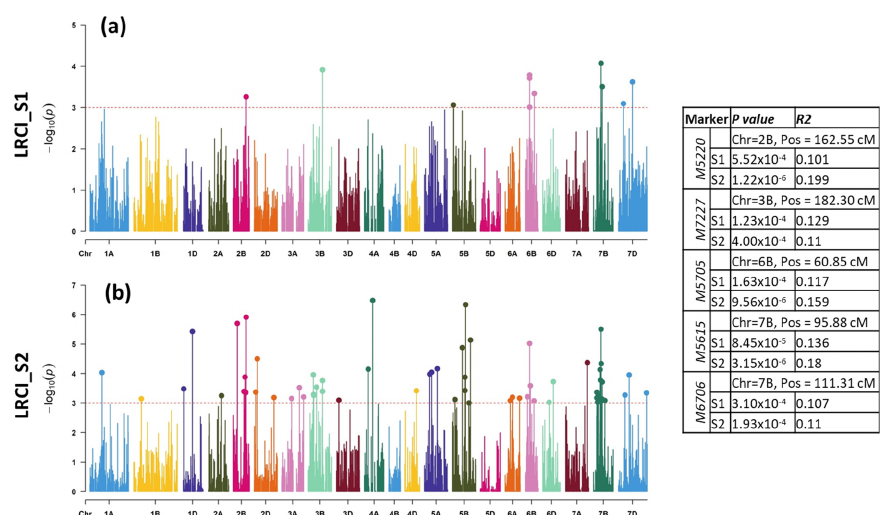
Figure 4. Genome-wide scan of ( a ) LRCI in S1 and ( b ) S2 in the form of Manhattan plots where the chromosomes are plotted at the bottom, and the thin dotted red line indicates significance level at p -value < 0.001 ( − log10 = 3 or more) beyond which an association is counted as true association (highlighted dots). Table on the right shows common MTAs between S1 and S2, showing marker names, chromosome number, position, p -value, and R 2 value in each season.